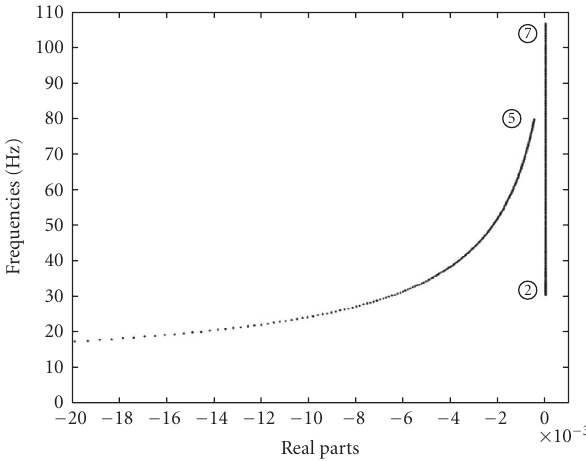
Figure 8: Decay rate plot for a two-bladed rotor.